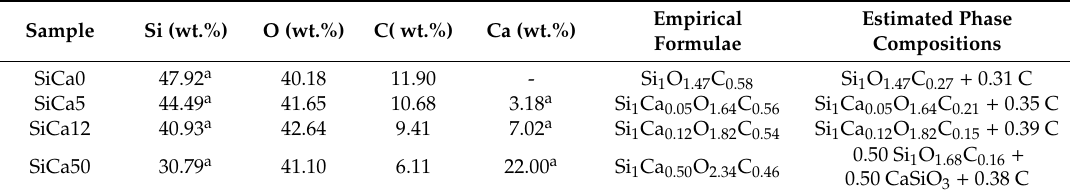
Table 3. Elemental contents, empirical formulae, and estimated phase compositions of the prepared silicon oxycarbide-based